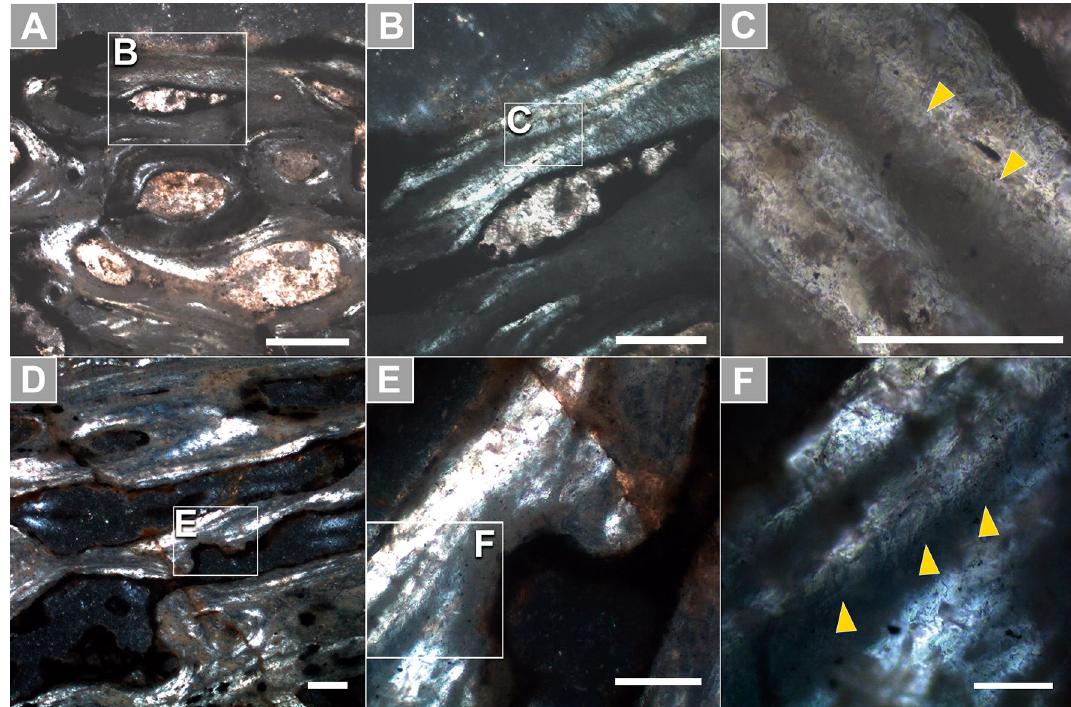
Figure 5. Occurrence of pneumosteum (arrows) in the posterior cervical vertebra of the saltasaurid titanosaur LPP-PV-0200. ( A – C ) Secondary bone in the internal centrum wall is comprised of pneumosteum entirely. ( D – F ) The trabeculae surrounding pneumatopores also consist solely of pneumosteum. Pneumosteal bone presents an undulose extinction and tiny asbestiform densely-packed ‘hair-like’ fibers. All micrographs are in polarized light under crossed Nicols. Scale bar in ( A ) 200 µm; in ( B , D ) 100 µm; in ( C ), ( E ) 50 µm; in ( F ) 20 µm. Photographs taken with Leica Application Suite (LAS) EZ version 1.6.0 X64. Figures were generated with Adobe Photoshop CC version 22.5.1 X64.